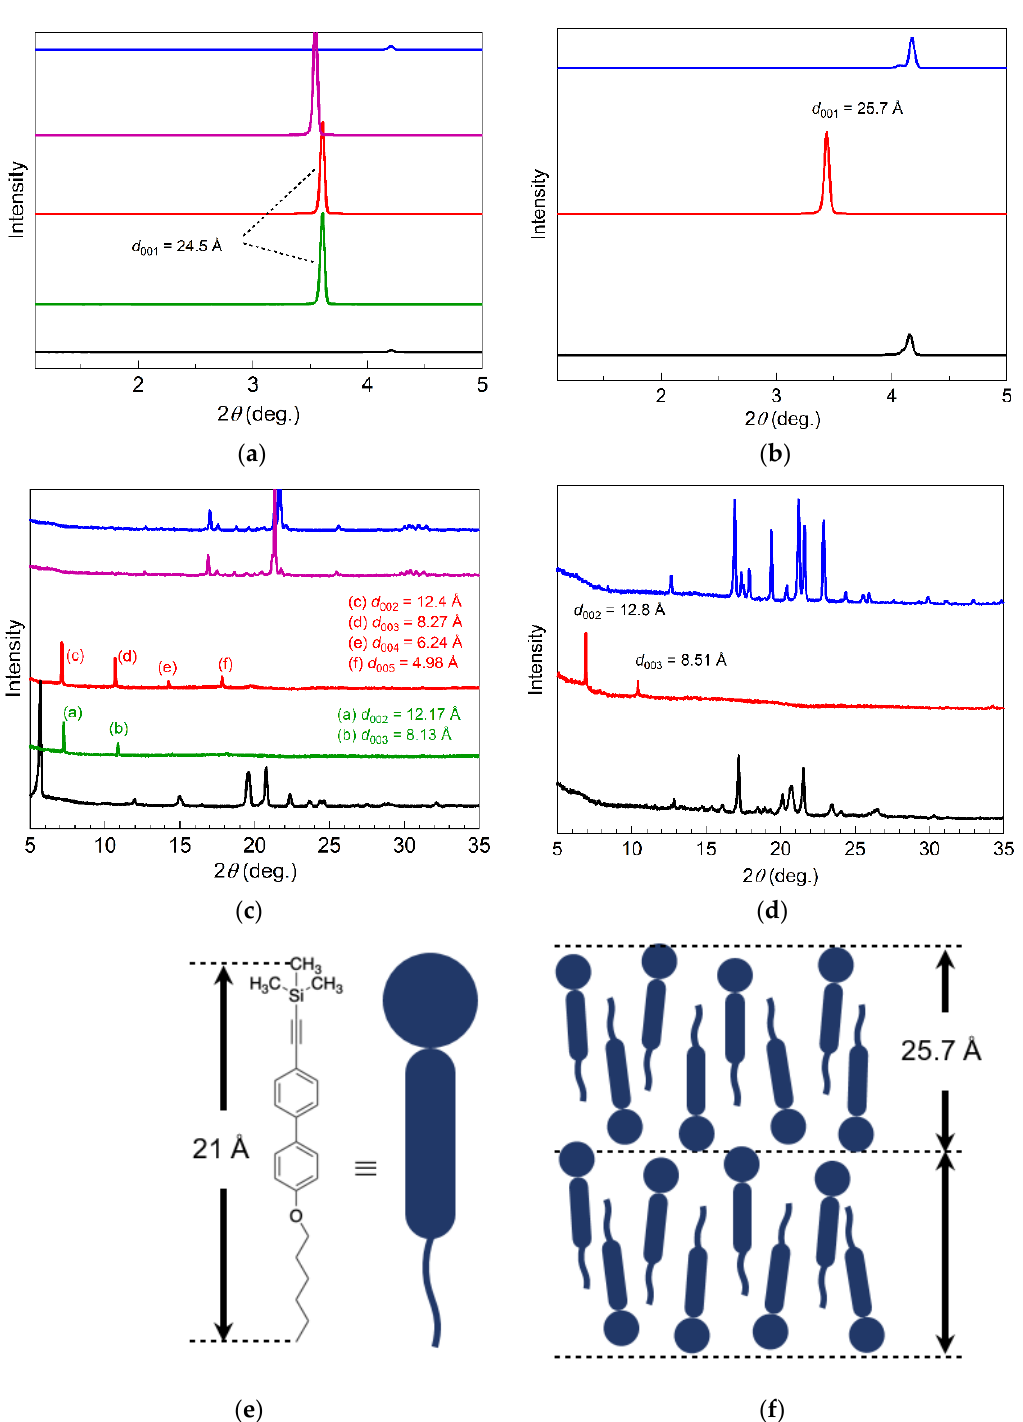
Figure 5. X-ray diffraction (XRD) patterns at various temperatures and plausible packing structure in the SmeA phase. Small-angle XRD patterns for ( a ) 5-BPTMS and ( b ) 6-BPTMS . Wide-angle XRD patterns for ( c ) 5-BPTMS and ( d ) 6-BPTMS . XRD measurements were performed in the temperature ranges of 30–38 °C (1st heating, Cry, black), 114–109 °C (1st cooling, SmeA, green), 96–92 °C (1st cooling, SmeX, red), 89–88 °C (1st cooling, Cry′, violet), and 31–30 °C (1st cooling, Cry, blue) for 5-BPTMS , and 23–51 °C (1st heating, Cry, black), 109–95 °C (1st cooling, SmeA, red), and 39–30 °C (1st heating, Cry, blue) for 6-BPTMS . ( e ) Molecular model of 6-BPTMS and ( f ) schematic model of the packing structure in the SmeA phase.